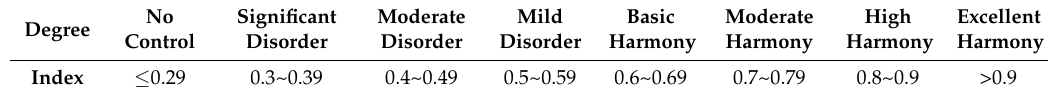
Table 2. Index and degree of Harmony (HD).